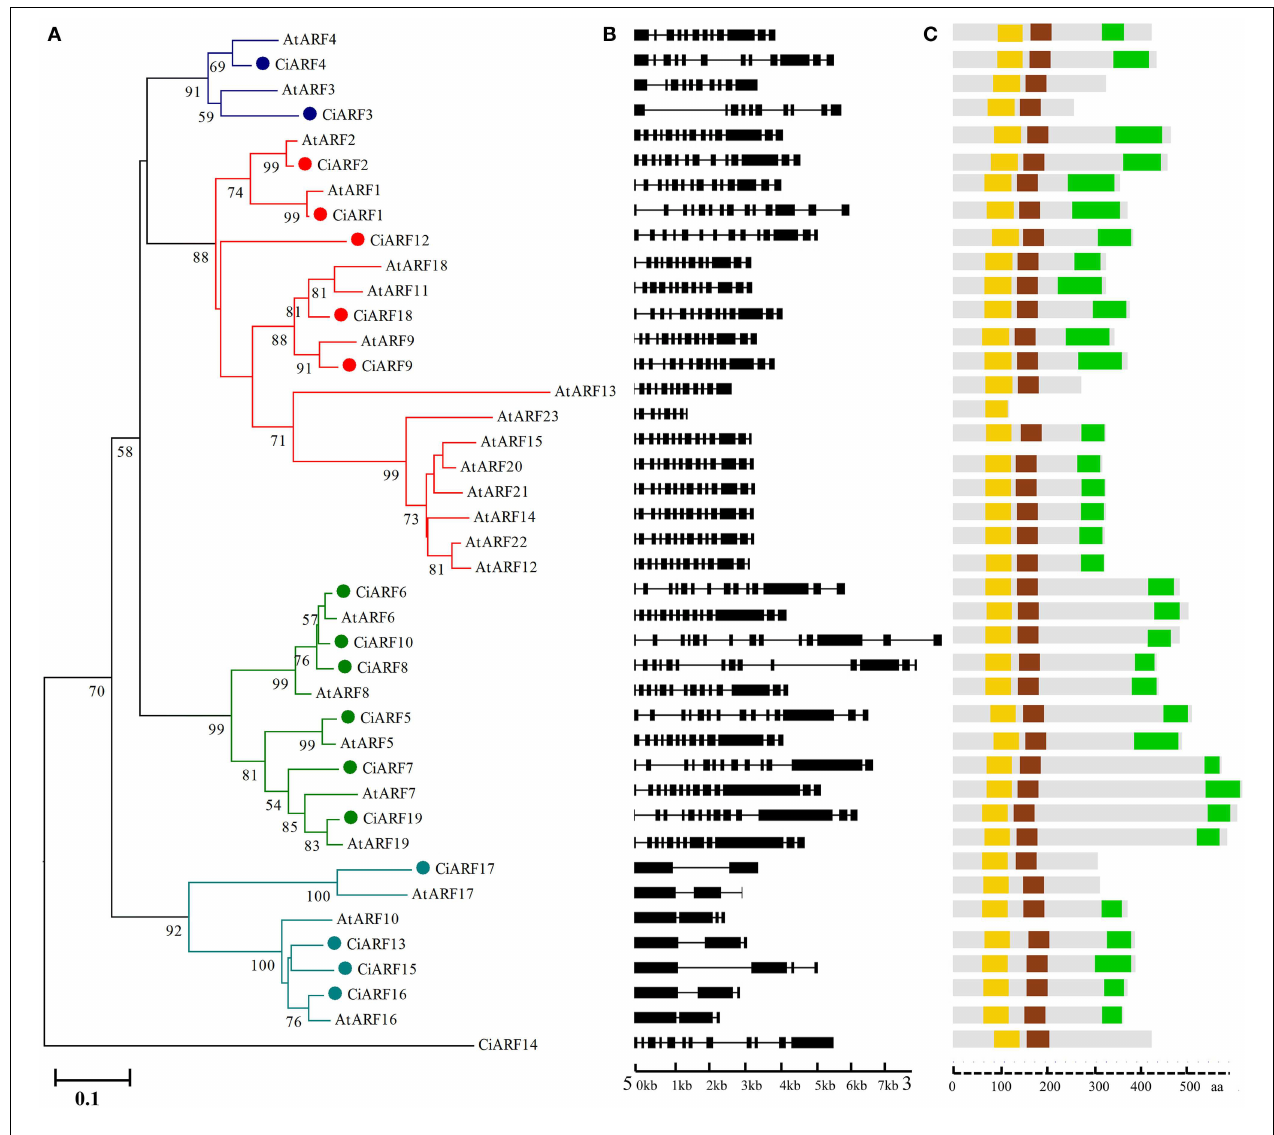
phylogenetic relationship. Lengths of exons and introns of each CiARF gene are displayed proportionally. The boxes represent exons; black lines represent introns. (C) Conserved motif analysis of ARF proteins from sweet orange and Arabidopsis according to the phylogenetic relationship. The DBD, ARF, and CTD domains are marked in orange, brown, and green,